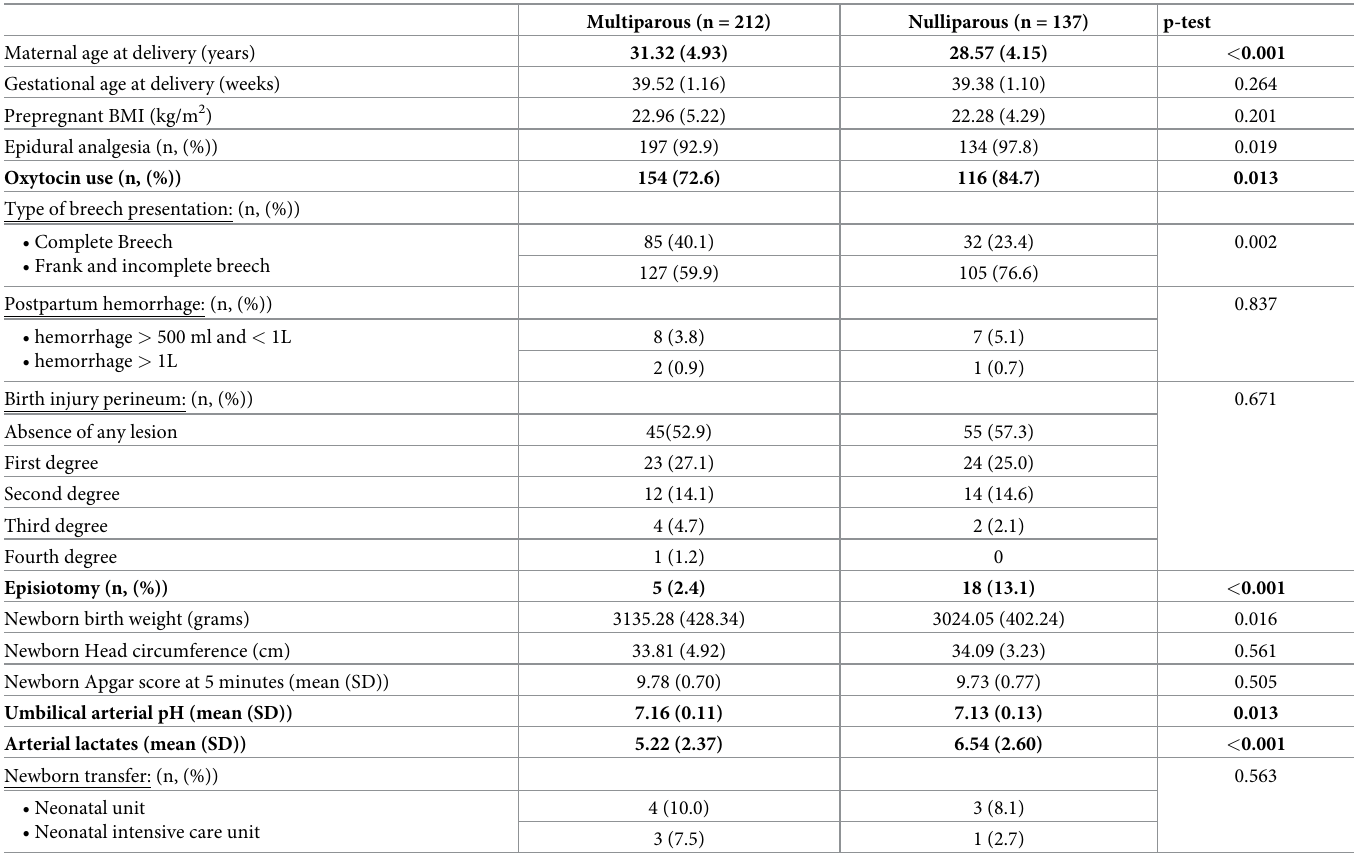
Table 1. Baseline characteristics of the study population by